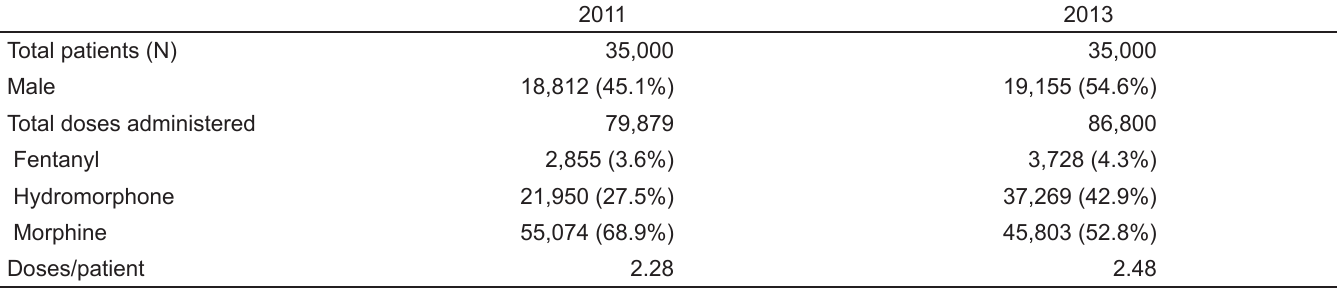
Table 1a. Demographics and composite data in study of opioid administration.